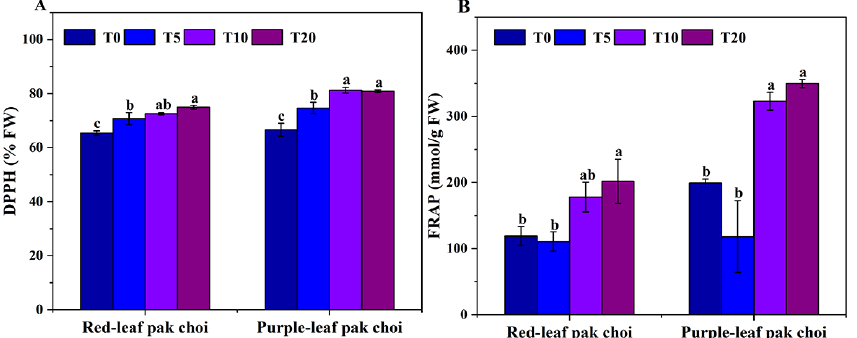
Figure 6. Effects of blue and UVA light on DPPH radical scavenging rate ( A ) and FRAP ( B ) of red- and purple-leaf pak choi. T0, T5, T10 and T20 mean 0 UVA with 50 B, 5 UVA with 45 B, 10 UVA with 40 B and 20 UVA with 30 B (μmol·m − 2 ·s − 1 ), respectively. Different letters mean statistical differences determined with Duncan’s multiple test at p < 0.05 among treatments. Error bars indicate ± SE ( n = 3).